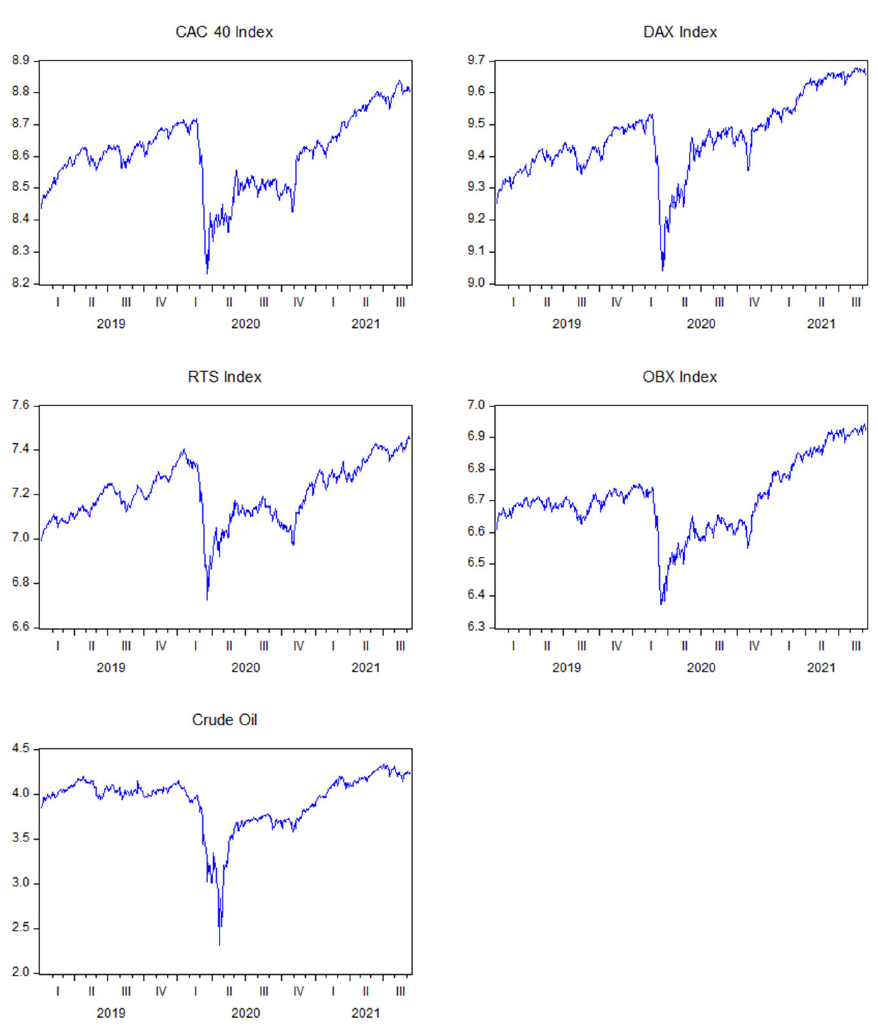
Figure 1. Price history (2019–2021).